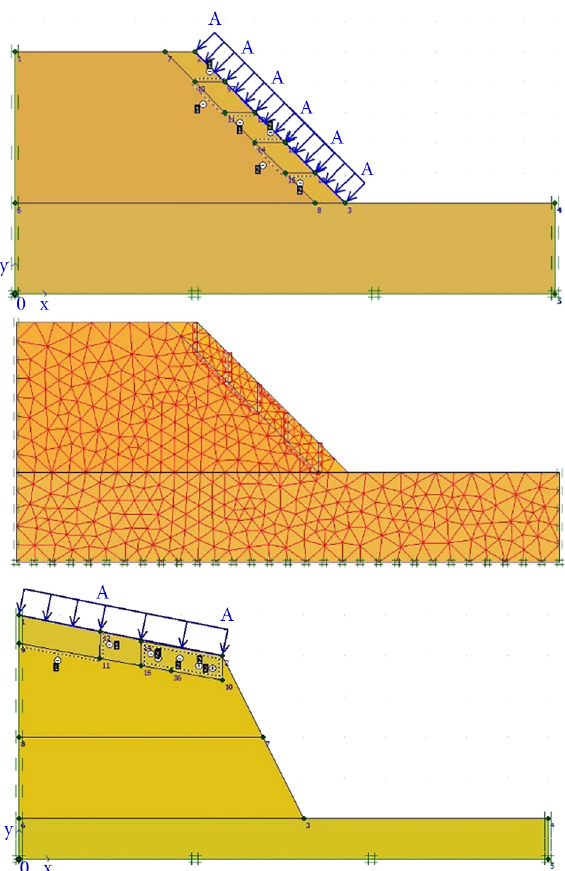
Figure 1. Entering data related to slope geometry and its elements and applying fine mesh for slope stability analysis